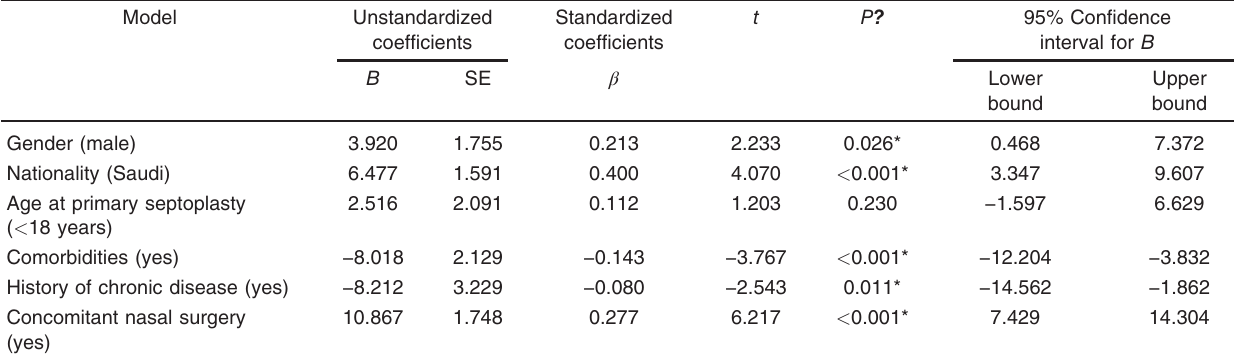
Table 4 Multiple linear regression to assess the effect of patient characteristics on the time between first septoplasty and recurrence ( n =